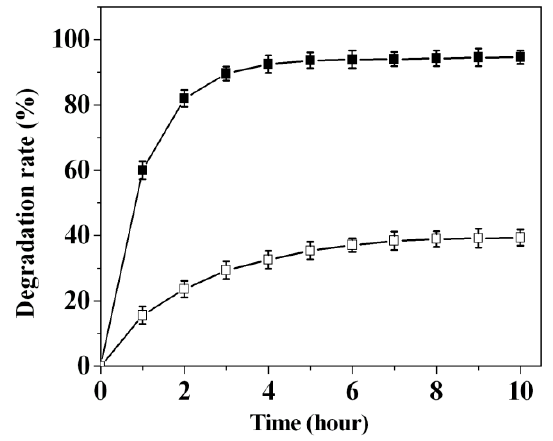
Figure 5. 2,4-DCP degradation rate using entrapped laccase ( ■ ) and free laccase ( □ ).